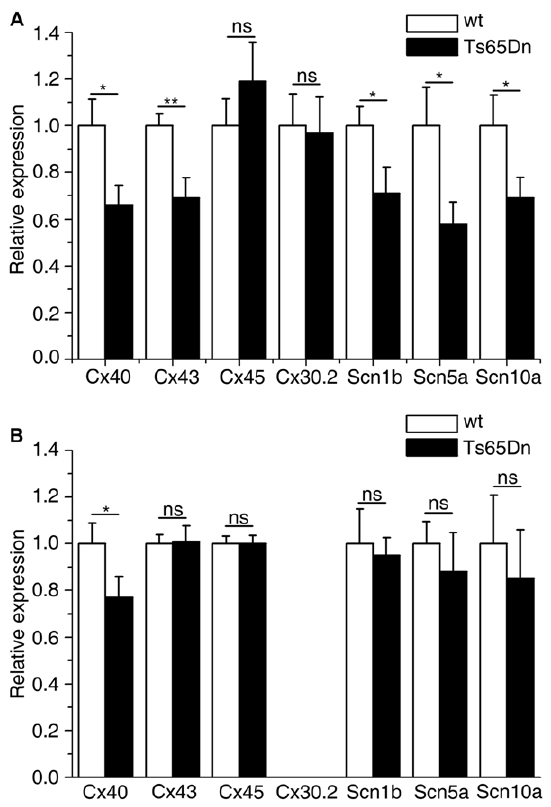
Figure 6. Atrial and ventricular connexins and sodium channel genes expression levels in wt and Ts65Dn mice. (A) Atrial; (B) ventricular. Connexins and sodium channels genes expression levels were assessed by qRT-PCR using RNA extracted from adult mice cardiac atria and ventricle separately. Ts65Dn show an overall decrease in connexin and sodium channel mRNA expression except for Cx45 and Cx30.2 in the atria. Cx40 expression level is reduced in the ventricles. No amplification was obtained for Cx30.2 in ventricle extracts confirming its atria specific expression pattern. Mean 6 sem with Student t-test P - values, N=7 and 5 for Ts65Dn and wt